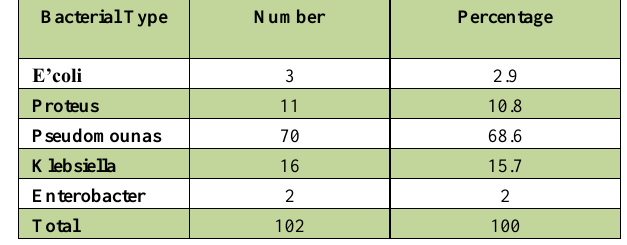
Table 6. Frequency Distribution of Cultivated Responses in Patients Admitted to ICU Ward of Rasht City.